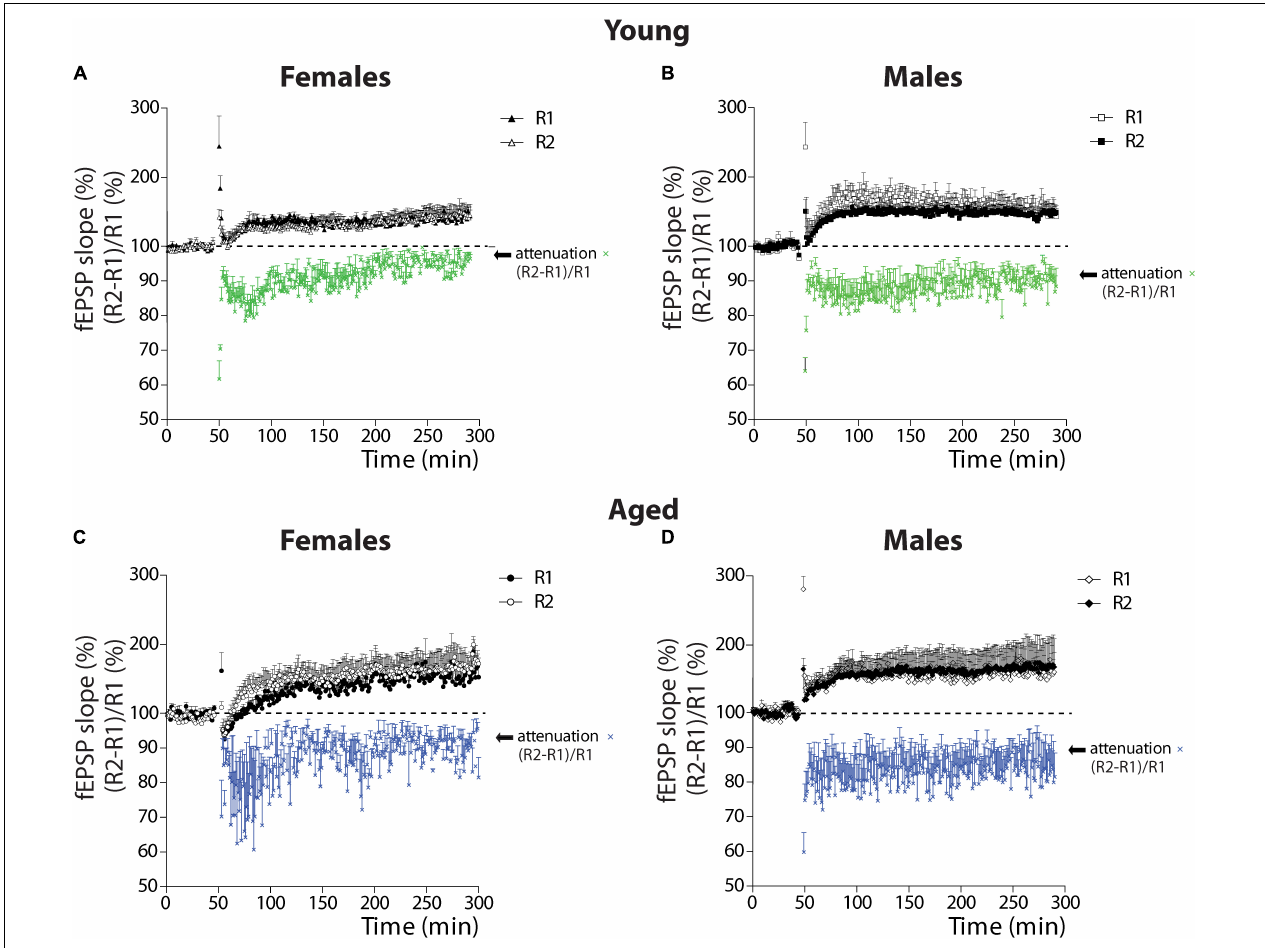
FIGURE 5 | Analysis of attenuation as a form of plasticity in young and aged female and male degus. (A–D) Plots of the relative contribution of R1 and R2 evoked responses (%) (black and white symbols) and the calculation of the attenuation as (R2-R1)/R1 (%) (colored symbols) in young female degus (A) , young male degus (B) , aged female degus (C) , and aged male degus (D) . Data represent the mean ± SEM (21 slices from n = 7 young n = 5 aged , and 21 slices from n = 7 aged ♀